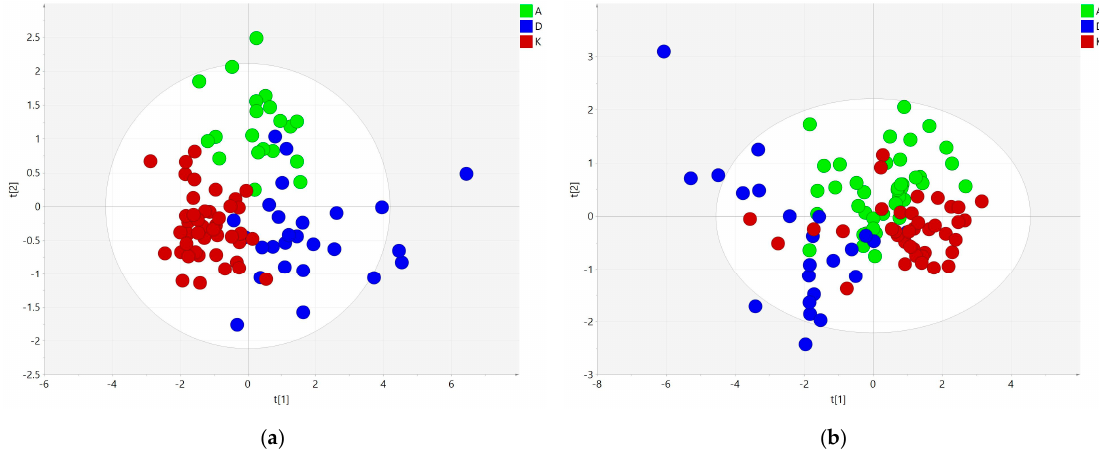
Figure 5. Supervised analysis on polar lipid subset. PLS-DA score plots of ( a ) female samples and ( b ) male samples. Group A in green, group D in blue, and group K in red. The markers separating groups in the female PLS-DA model (R 2 X = 0.501, R 2 Y = 0.575, Q 2 Y = 0.526) alongside FAHFAs were a number of different lipids. The highest importance Table 3. List of VIP polar lipids from the PLS-DA model based on female samples only. was observed for LPIs such as in the whole sample set, plasmenyl PCs, and plasmenyl PSs that were not important for the whole lipid set. In addition, the number of LPCs, PCs, and PEs were important for the female model. For the male PLS-DA model (R 2 X = 0.729, R 2 Y = 0.426, Q 2 Y = 0.333), the important markers were a number of lysophospholipids, LPCs, and LPEs containing polyunsaturated fatty acids. All markers are summarized in Table 3 for the female model and Table 4 for the male model.